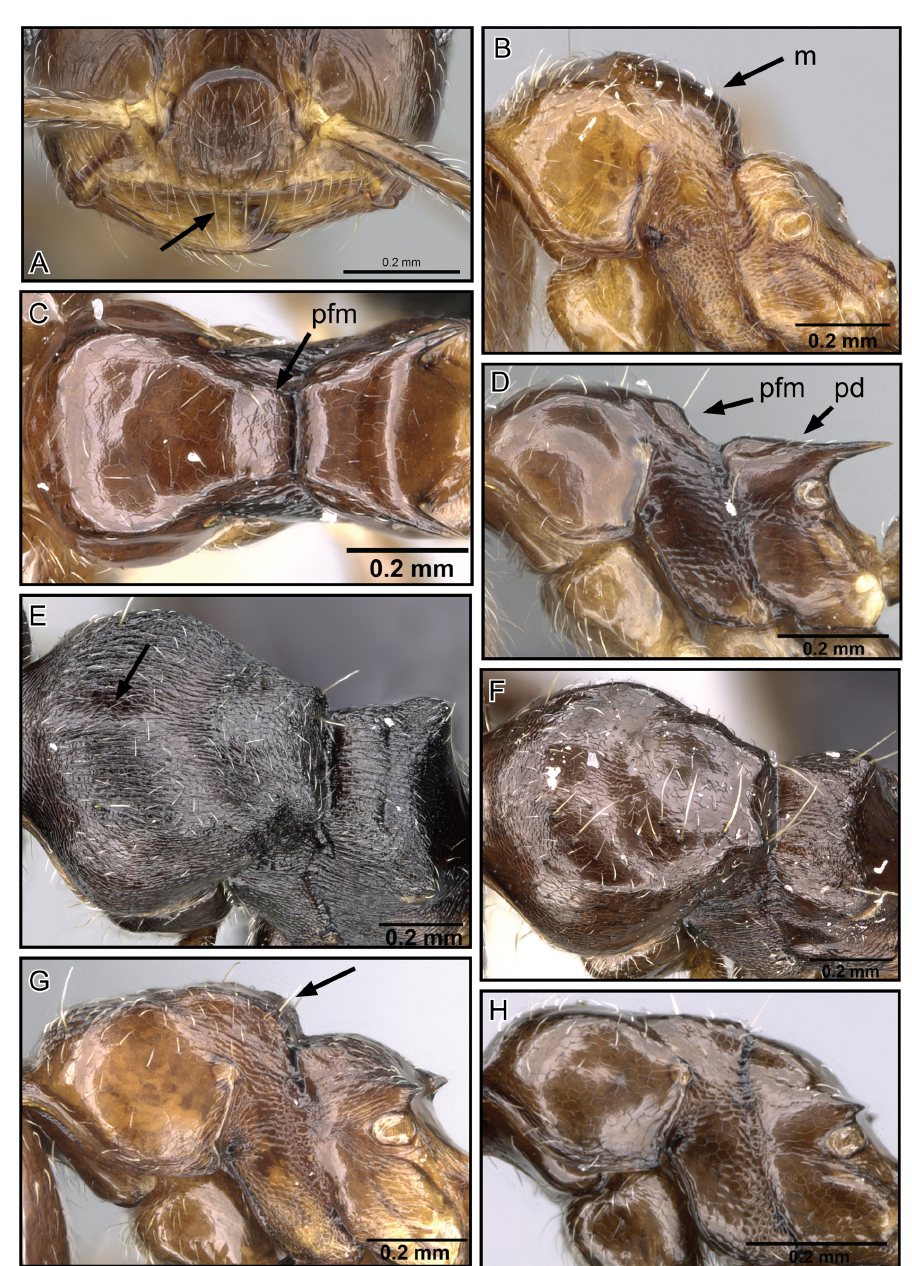
Fig. 4. Key to subgenera & species-groups of Malagasy Crematogaster (part II); key to the species of the C. degeeri -assemblage (part I). A. Median portion of clypeus lacking flange [ C. kelleri Forel, 1891, CASENT0466090]. B. Propodeal spines absent; mesonotum (m) greatly raised with respect to pronotum and propodeum [ C. tsisitsilo Blaimer, 2013, CASENT0120279]. C. Posterior face of mesonotum (pfm) long; promesonotal suture absent [ C. kelleri , CASENT0466090]. D. Promesonotum forming a straight plane, posterior face of mesonotum (pfm) abruptly sloping into metanotal groove, propodeal spines situated high on propodeum (pd) [ C. kelleri , CASENT0466090]. E. Pronotum dorsally with distinct median longitudinal groove [ C.mafybe sp. nov., CASENT0317762]. F. Pronotum dorsally without median longitudinal groove [ C. lobata Emery, 1895, CASENT0125498]. G. Propodeum distinctly set off from promesonotum in lateral view [ C. malahelo sp. nov., CASENT0317768]. H. Propodeum not distinctly set off from promesonotum in lateral view [ C. dentata Dalla Torre, 1893 stat. nov.,